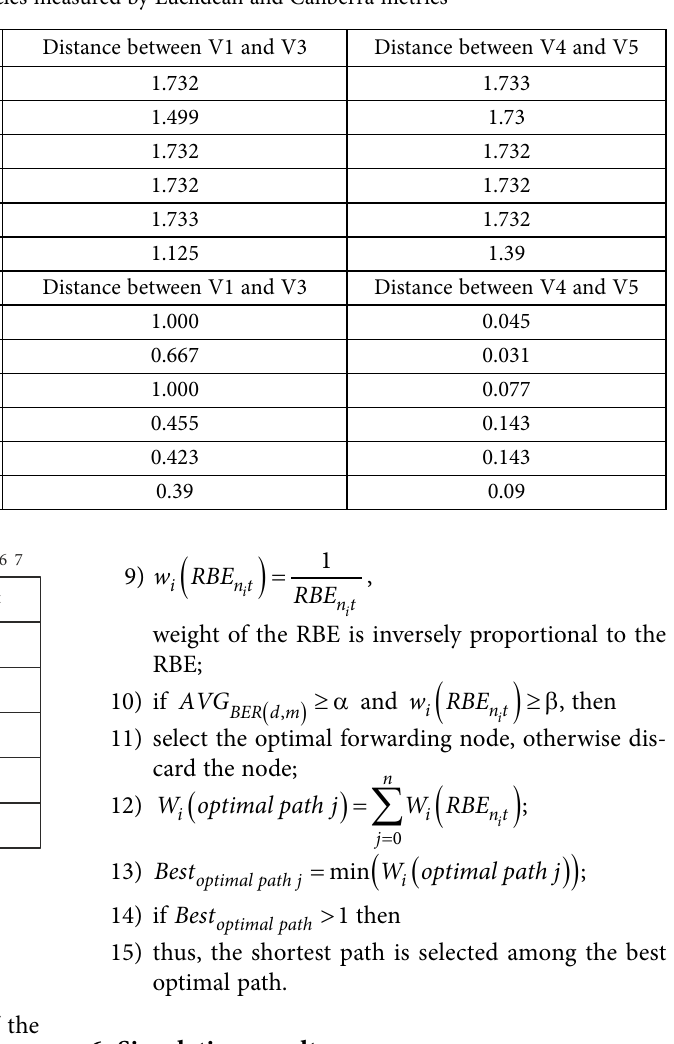
Table 1. Distance between the vehicles measured by Euclidean and Canberra metrics